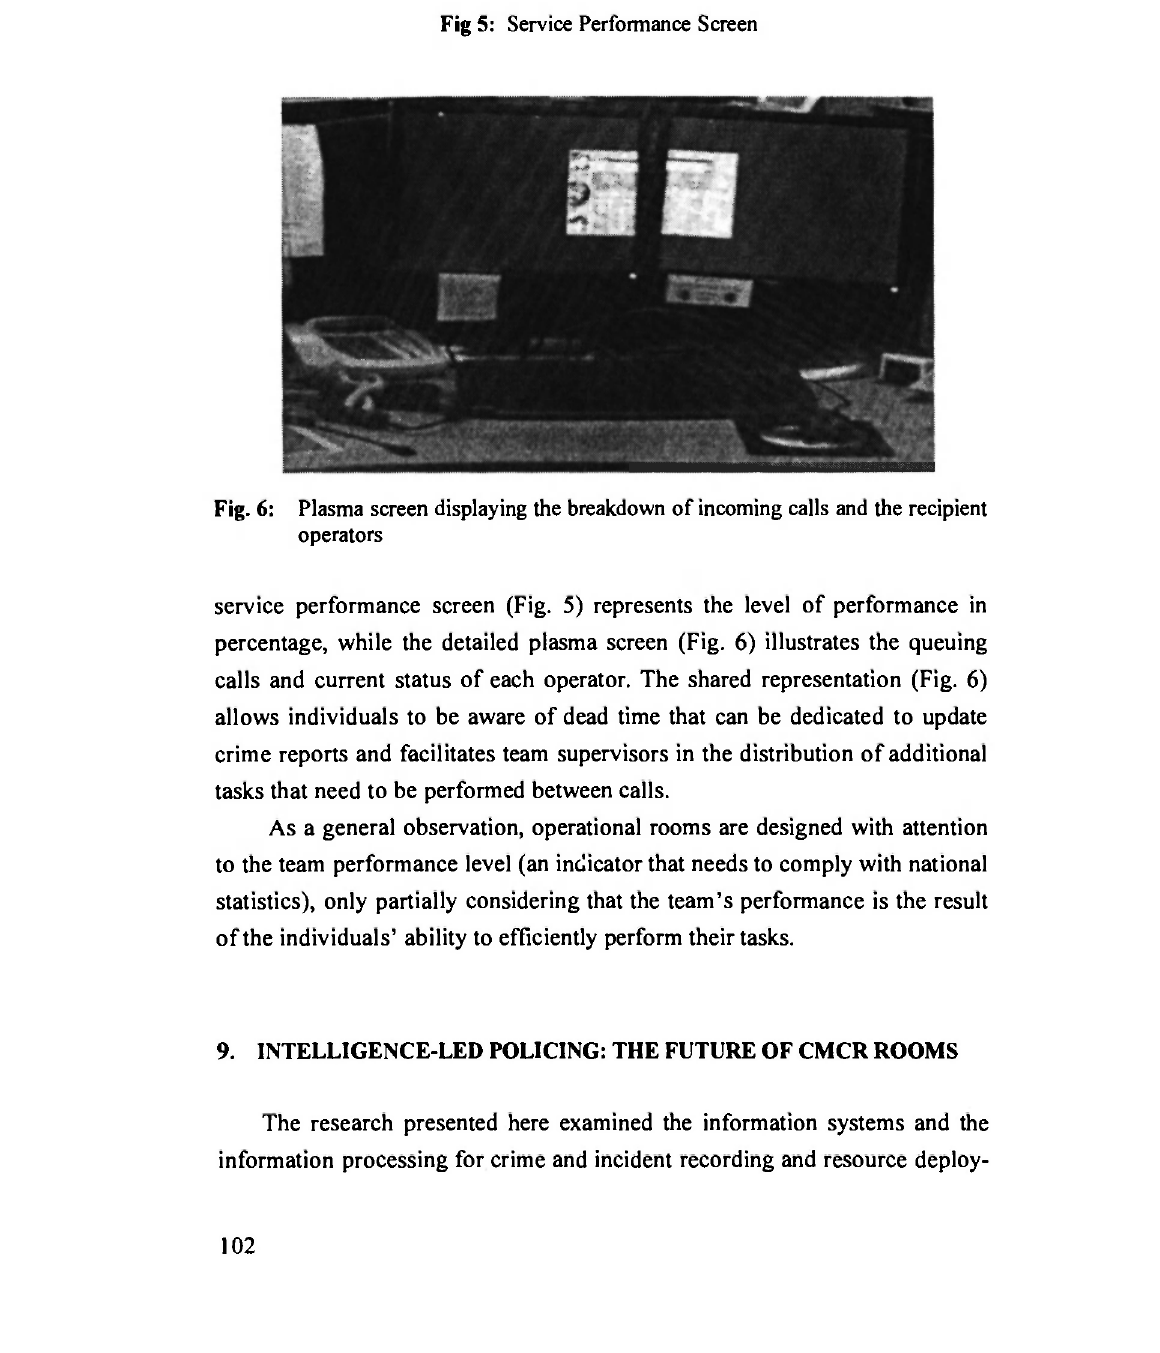
Fig 5: Service Performance Screen